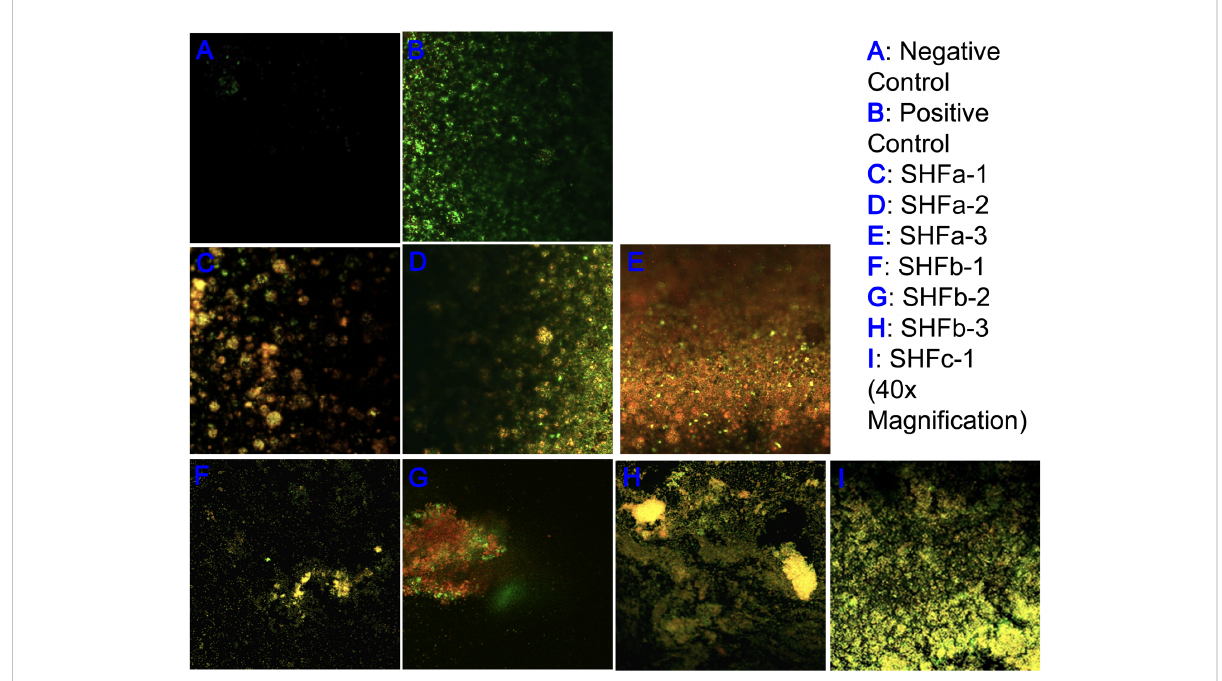
FIGURE 3 Representative confocal laser scanning microscopy images of (A) negative control and (B) E faecium 1449 bio fi lm matrices treated with vehicle and Ag-hydrosol NP Sample (C) SHFa-1 (14.2 mg/L), (D) SHFa-2 (14.2 mg/L), (E) SHFa-3 (14.2 mg/L), (F) SHFb-1 (26.5 mg/L), (G) SHFb-2 (26.7 mg/L), (H) SHFb-3 (26.8 mg/L) and (I) SHFc-1 (123 mg/L). Original magni fi cation 40